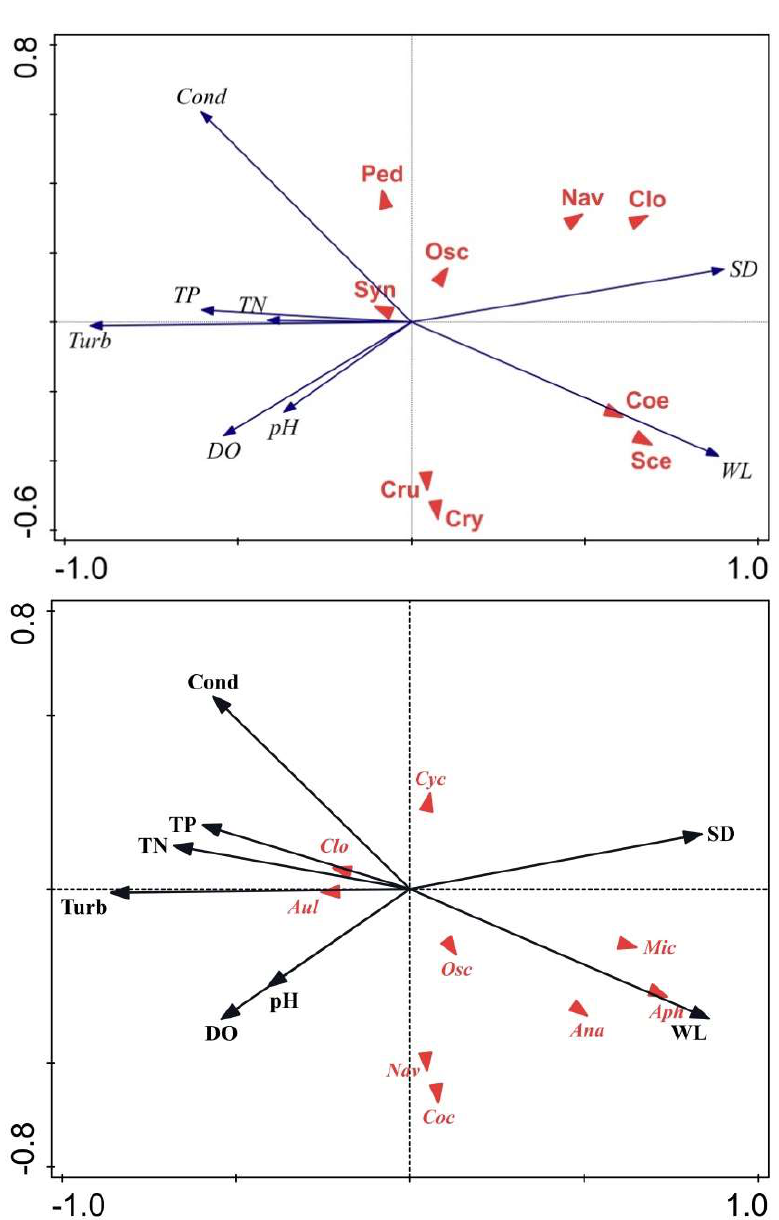
Figure 6. Phytoplankton species (triangle symbol) and environmental factor (black lines with arrowhead) biplot based on RDA before and after the flooding of Huayanghe Lakes. Abbreviations used in the figure: WL, water level; SD, Secchi depth; Cond, conductivity; DO, dissolved oxygen; TN, total nitrogen; TP, total phosphorus; and Turb, turbidity. Taxonomic groups: Cry, Cryptomonas ovata ; Cru, Crucigenia sp.; Coe, Coelastrum reticulatum ; Sce, Scendesmus sp.; Clo, Closterium sp.; Nav, Navicula sp.; Osc, Oscillatoria sp.; Syn, Synedra sp.; Ped, Pediastrum sp.; Cyc, Cyclotella sp.; Aul, Aulacoseira granulata , Ooc, Oocystis lacustris ; Ana, Anabaena sp.; Mic, Microcystis sp.; and Aph, Aphanizomenon flosaquae (the regular hydrological cycle is shown above, and the flood period is shown below). During the regular hydrological cycle, the relative density of Navicula sp., Closterium sp., Coelastrum reticulatum , and Scendesmus sp. were positively associated with SD and WL. Other dominant species— Crucigenia sp., Cryptomonas ovata, and Cryptomonas erosa —presented a notably positive relationship with Cond. Closterium sp., Aulacoseira granulata , Navicula sp., Cocystis lacustris, and Cyclotella meneghiniana were related to Turb, TN, and TP. Navicula sp. and Oocystis lacustris were related positively to DO and pH, the same as Microcystis sp., Aphanizomenon sp., and Anabaenopsis sp. in the extreme hydrological